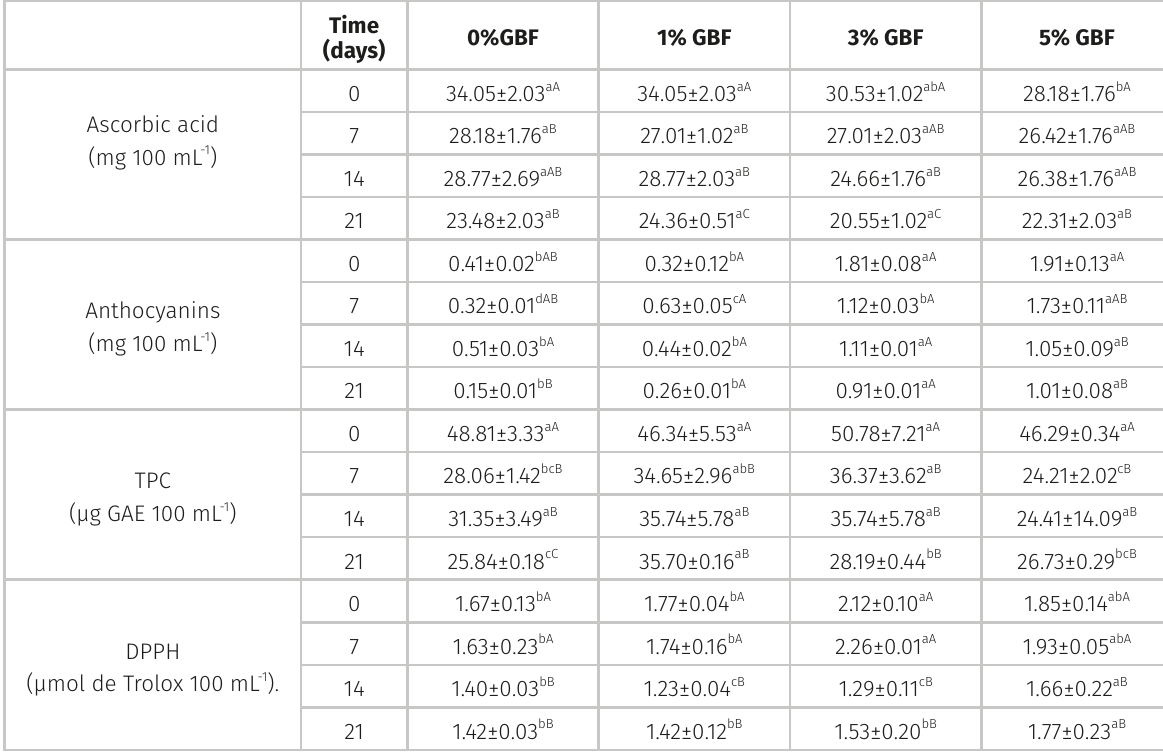
Table II. Ascorbic acid, anthocyanins, total phenolic compounds (TPC) and antioxidant activity by DPPH method of guava juice formulations containing 0, 1, 3 and 5% of guava by-product (GBF) at 0, 7, 14 and 21 days of storage at 4 °C